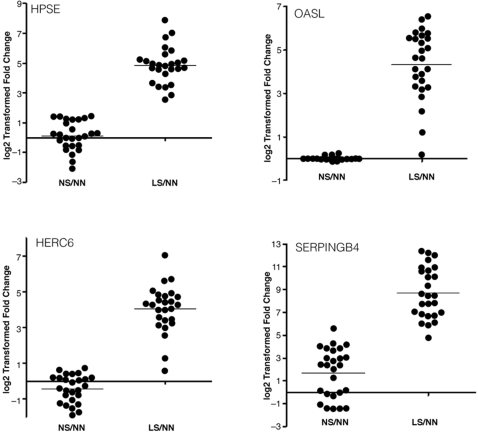
Relative expression of selected genes.Shown are three type I IFN–inducible genes (HPSE, OASL, and HERC6) and 1 gene that is not type I IFN–inducible (SERPINB4) in lesional skin (LS) compared with nonlesional skin (NS) in psoriatic patients, and in NS compared with skin from healthy donors (NN) based on microarray data. The fold changes of these genes in LS are compared with their paired NS, and NS is compared with the average of 21 NN controls. The horizontal bars represent the average fold change. The P values for the relative expression of HPSE, OASL, HERC6, and SERPINB4 between NS and NN, and between LS and NS are (listed in pairs): 0.468, <0.00001; 0.376, <0.00001; 0.03, <0.00001; 0.0002, <0.00001, respectively.